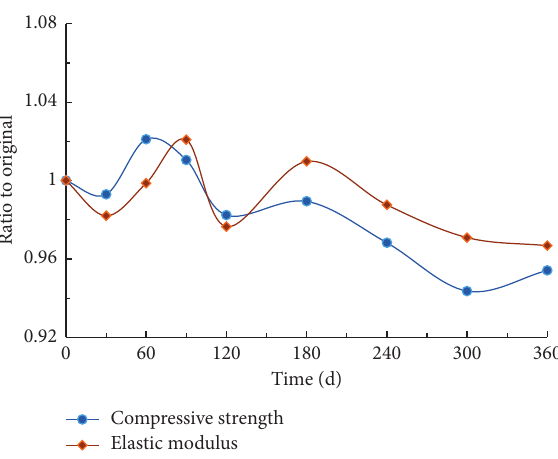
Figure 4: Variation of mass change of CGB soaked in